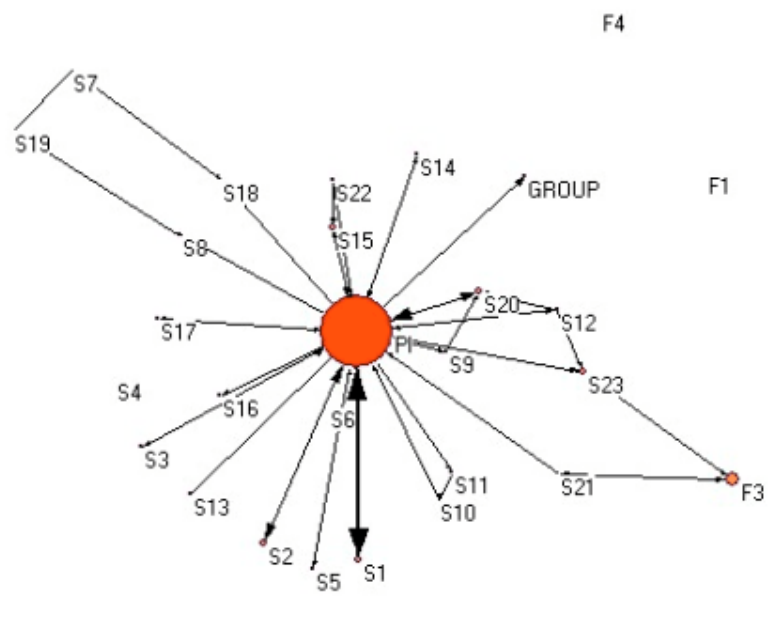
Figure 2. Face-to-faceF2F Session 2 Participation Pattern Diagrams for 30 minutes of processing after the activity. “S” refers to the students, “PI” refers to the principle instructor, and “F” refers to the